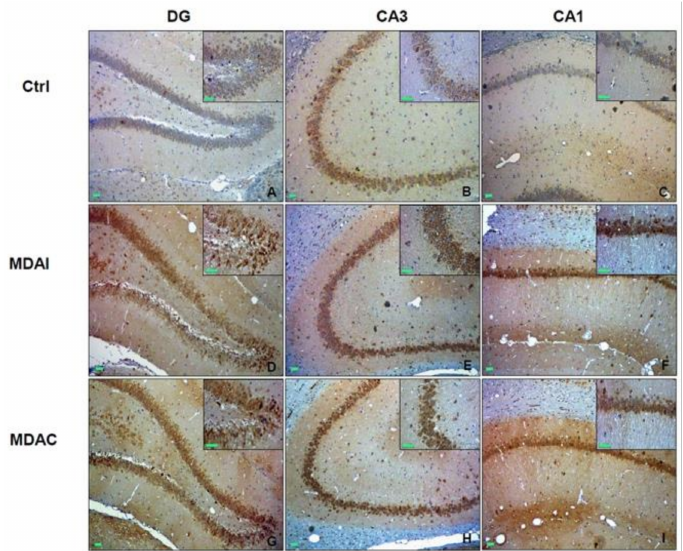
Figure 2. Hsp60 in experimental temporal lobe epilepsy. Shown are the levels and preferential localization of Hsp60 in control non-stimulated rats (ctrl) and in maximal dentate activation (MDA)- stimulated rats. ( A – C ). Immunohistochemical staining for Hsp60 in the hippocampus of control non-stimulated rats; DG, dentate gyrus; CA3, Cornu Ammonis area 3; CA1, Cornu Ammonis area 1. ( D – F ). Microphotographs of Hsp60 levels in the hippocampus of MDA-stimulated rats, ipsilateral to the perforant pathway stimulation (MDAI). ( G – I ). Microphotographs of Hsp60 levels in the hippocampus of MDA-stimulated rats, contralateral to the perforant pathway stimulation (MDAC). As shown in the microphotographs A–C and in the corresponding insets, in ctrl animals, Hsp60 was detected in all the hippocampal sectors. In the DG, Hsp60 immunoreactivity was in the granular cell layer, whereas, in the CA3 and CA1 sectors, it was, for the most part, in the pyramidal cell layer. The images of MDA-stimulated rats ( D – I ) and the corresponding insets show that the Hsp60 immunoreactivity was increased in the DG, CA3, and CA1 sectors in MDAI and MDAC compared to ctrl rats. This Hsp60 increase was observed in neuron somata and neuropil. Green scale bar = 100 µ m. Reproduced from reference [57], published under the terms and conditions of the Creative Commons Attribution License (CC